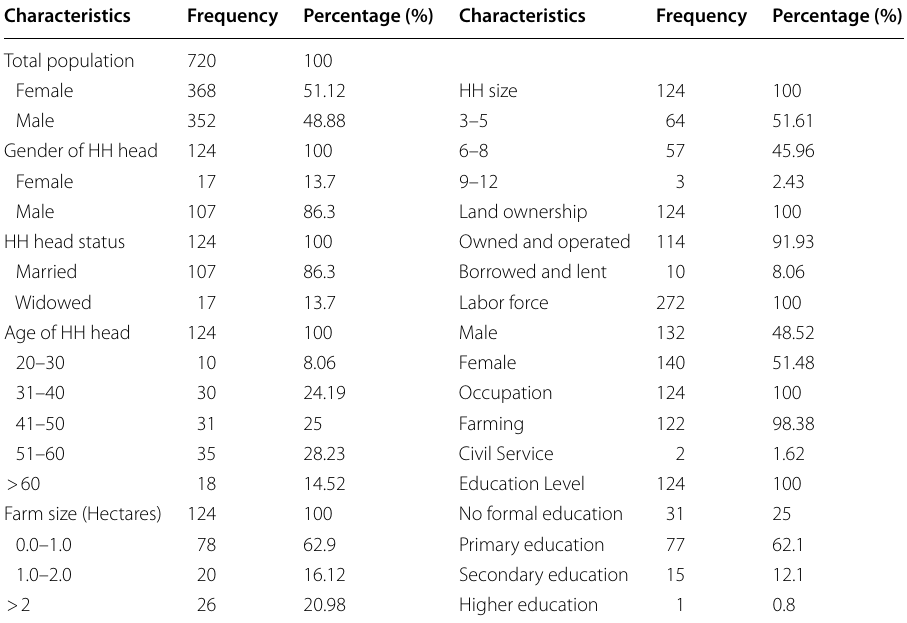
Table 1 Socio-economic characteristics of the study village (2016). Source: author and Household Survey Data, March 8, 2016